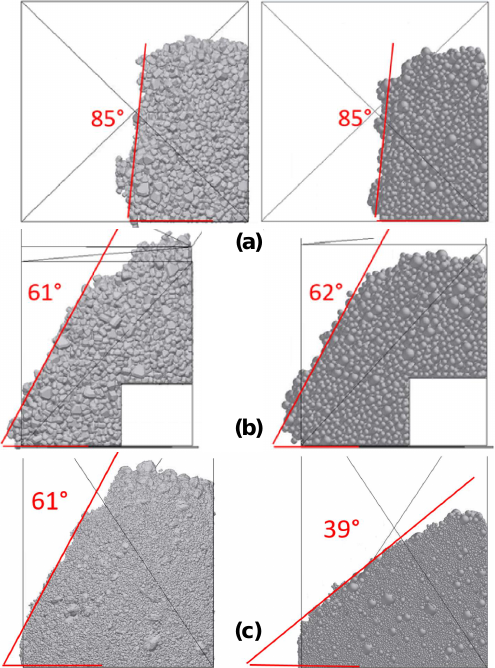
Figure 16. Discharge from a ledge test (rock box) as adapted from [128], showing ( a ) the shear (drained) angle in the upper box, ( b ) the dynamic angle of repose in the lower box for the fine sub- material, and ( c ) the dynamic angle of repose of the blended fine-coarse material. In all three cases, the multi-sphere particles are shown on the left and the spherical particles on the right. Reproduced with permission from A.